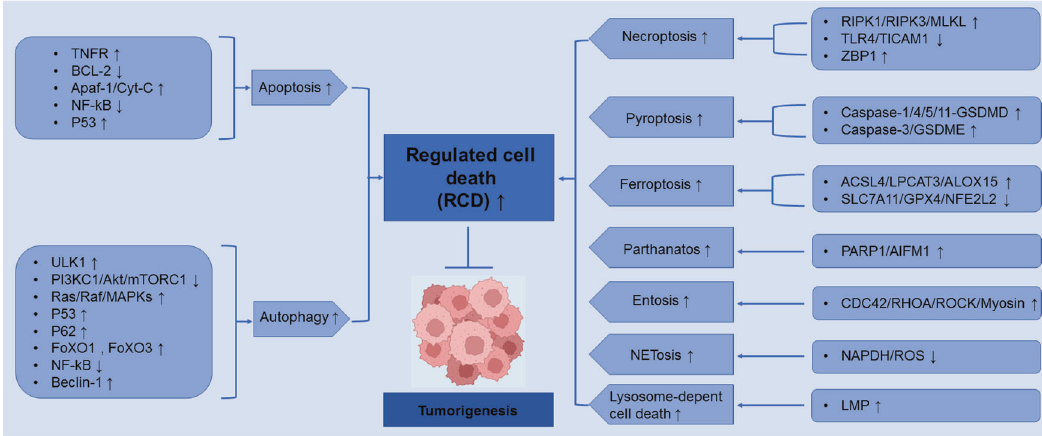
Fig. 1 Crucial signaling pathways of RCD subroutines in